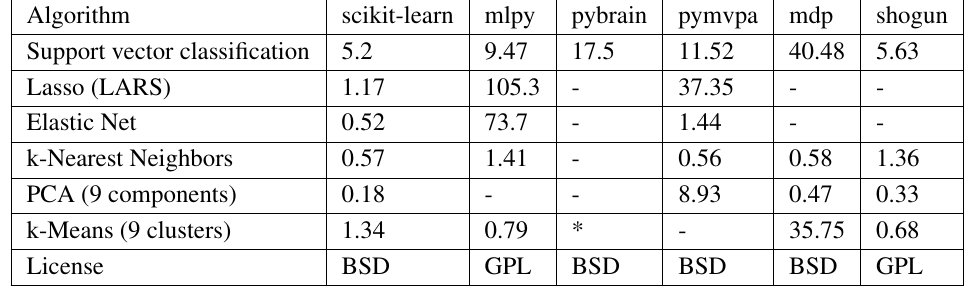
Table 2. Comparison between Python-based ML modules (classes time efficiency andlicense) (Pedregosa et al. 2011). Algorithm